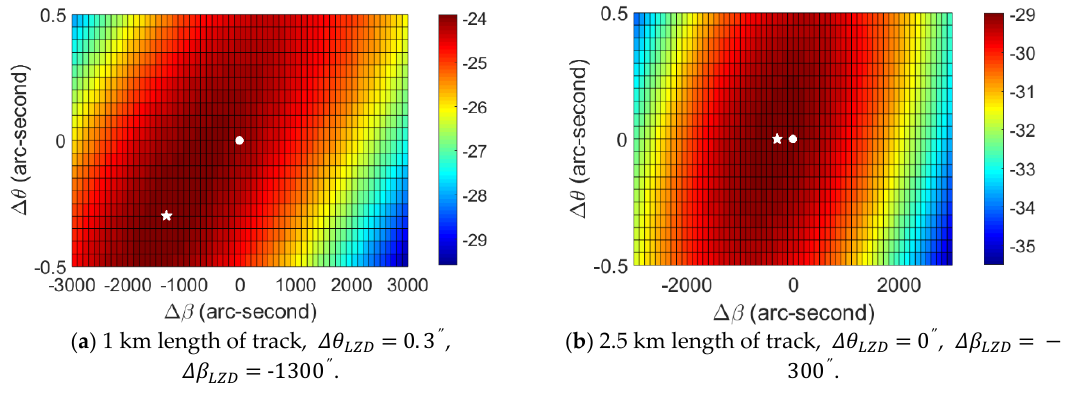
” corresponds to the ★